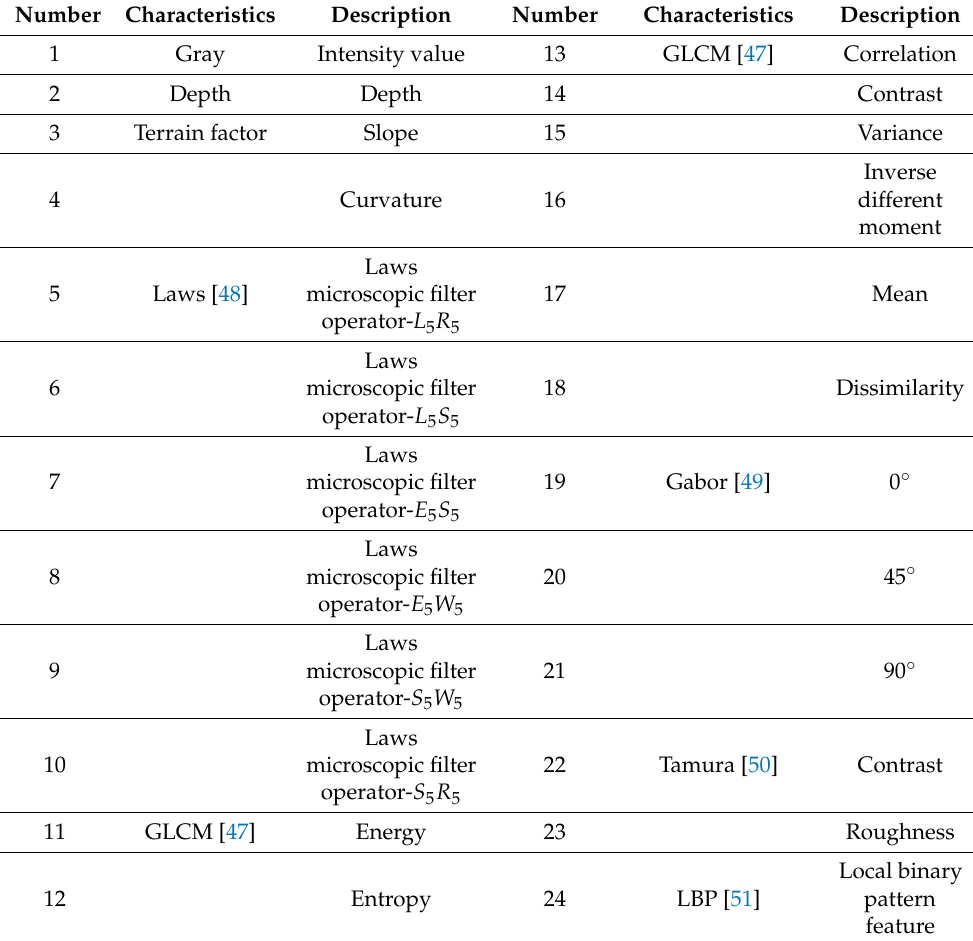
Table 1. Statistical table of 24-dimensional characteristic